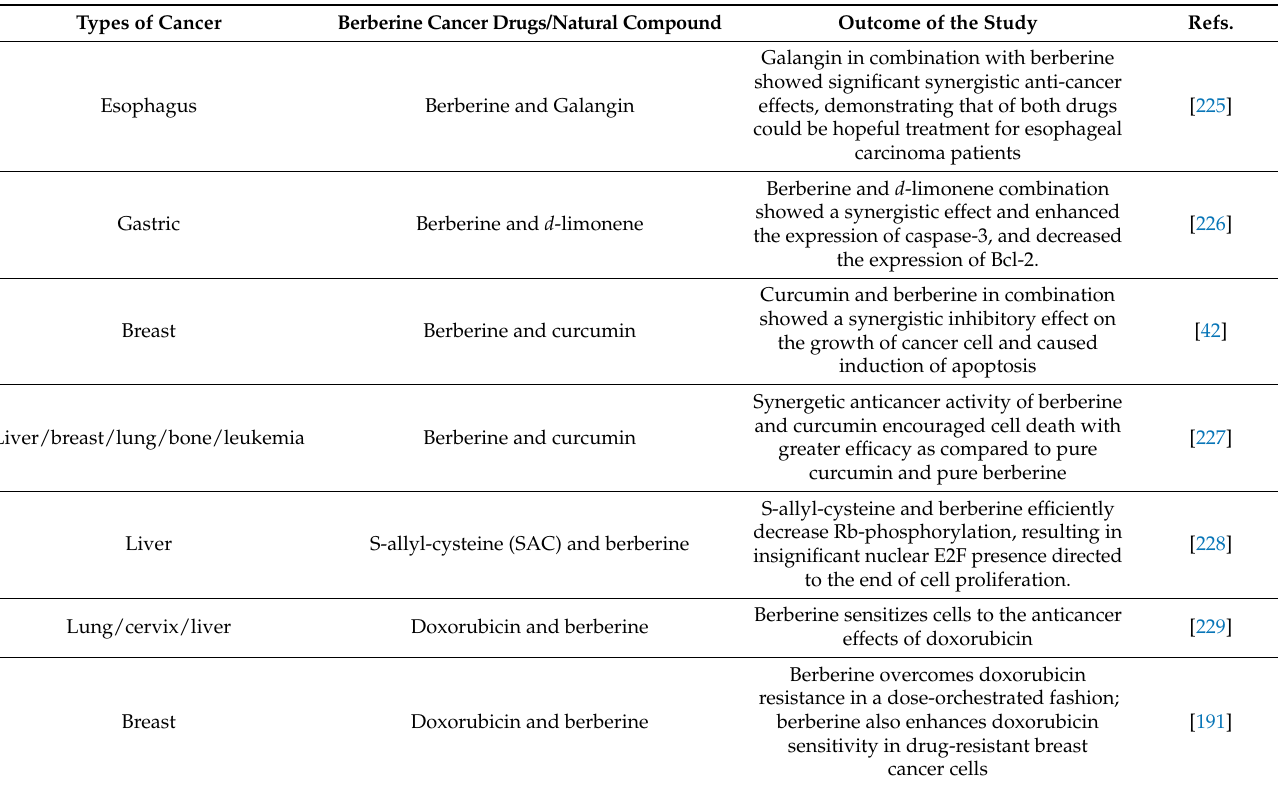
the effectiveness of cancer